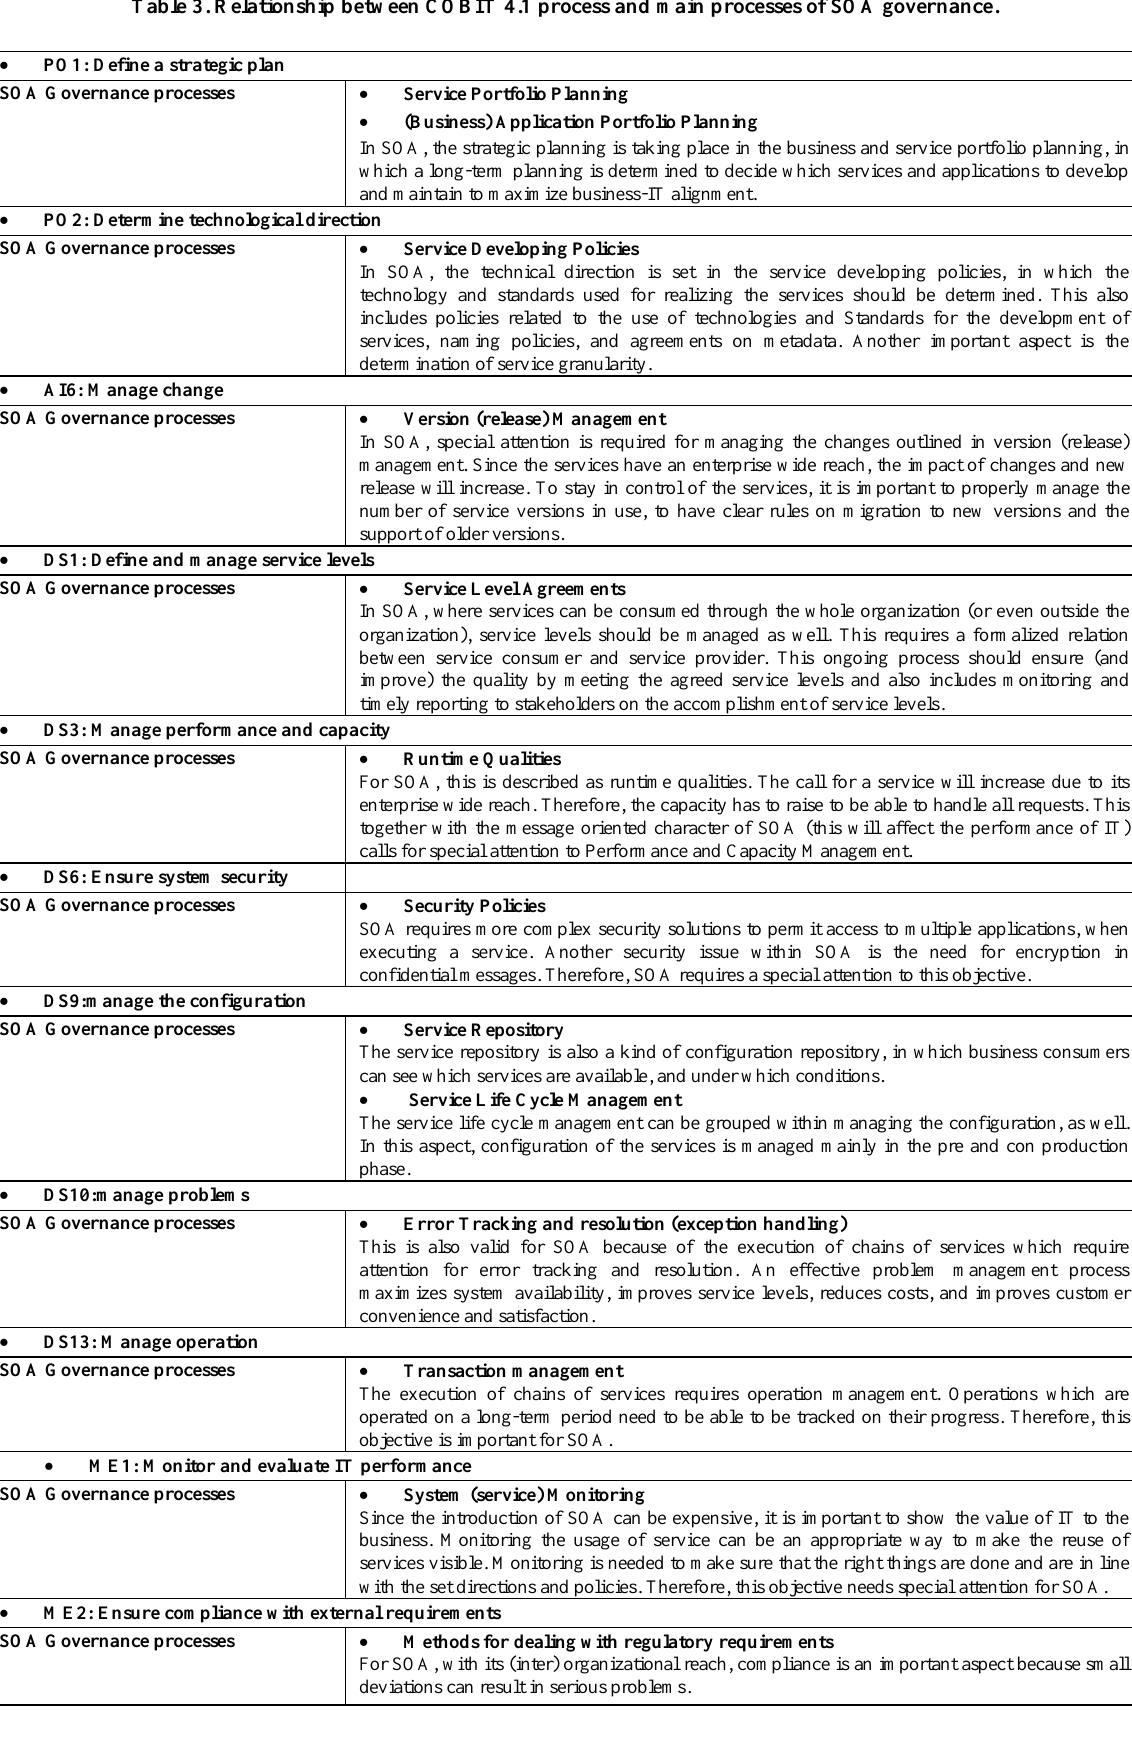
Table 3. Relationship between COBIT 4.1 process and main processes of SOA